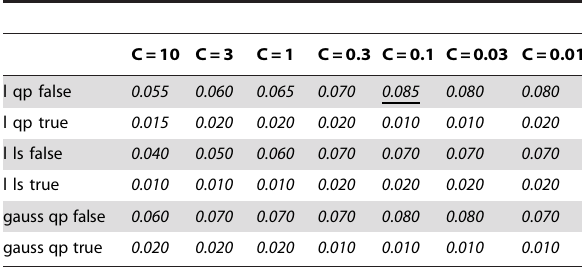
Table 1. Correlations for each parameter combination used for optimization the